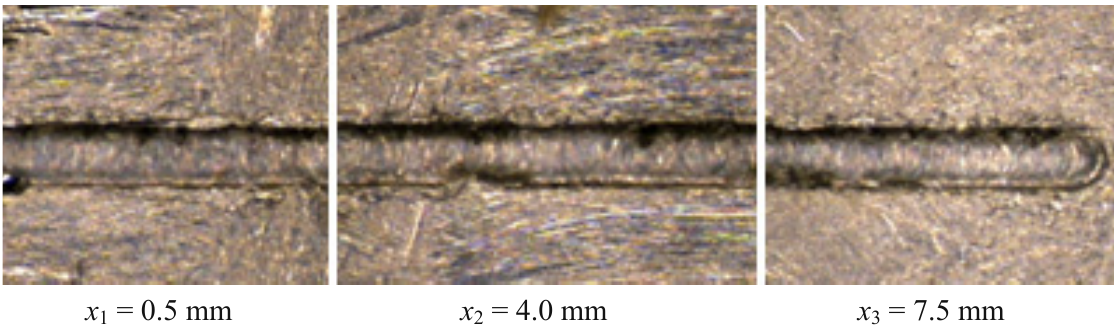
Figure 9. Channel burr formation map. x = micro-channel